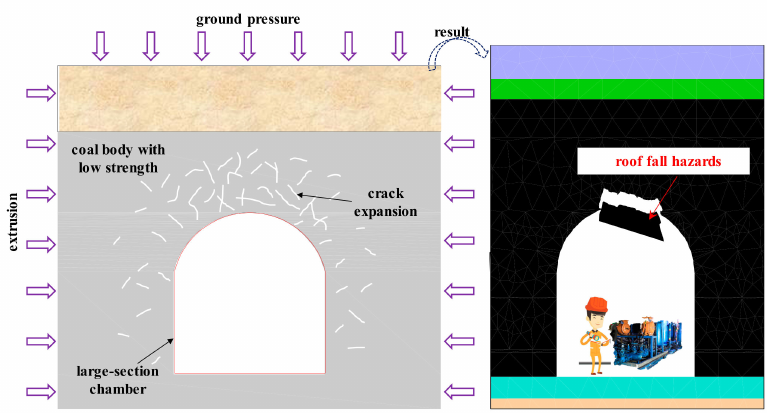
Figure 1. Crack formation and roof fall hazard